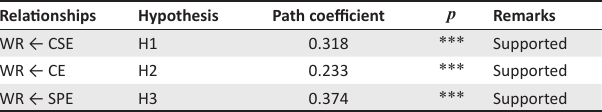
CSE, career self-efficacy; CE, career exploration; SPE, self-perceived employability; WR, work readiness. *** , significance level p < 0.01.